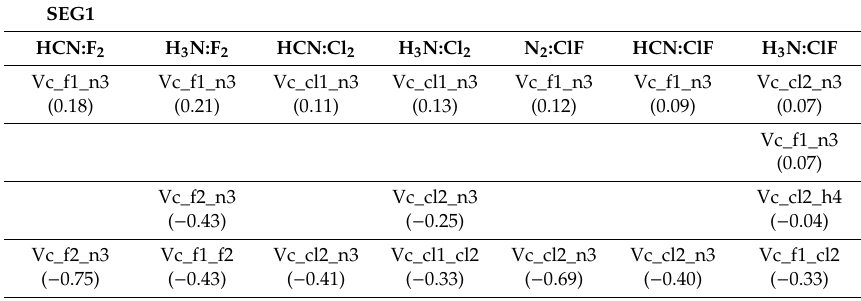
Table 6. REG analysis of the correlation (V c ) terms only, both intra- and interatomic. For each complex, the largest two energies are listed (most positive and most negative REG value by absolute value). The REG values are shown in parentheses. The atomic labeling follows X 1 –X 2 ··· N 3 − etc. where X = Cl or F, and the numeric labels of atoms not marked in this core common scheme increase while moving away from X inner